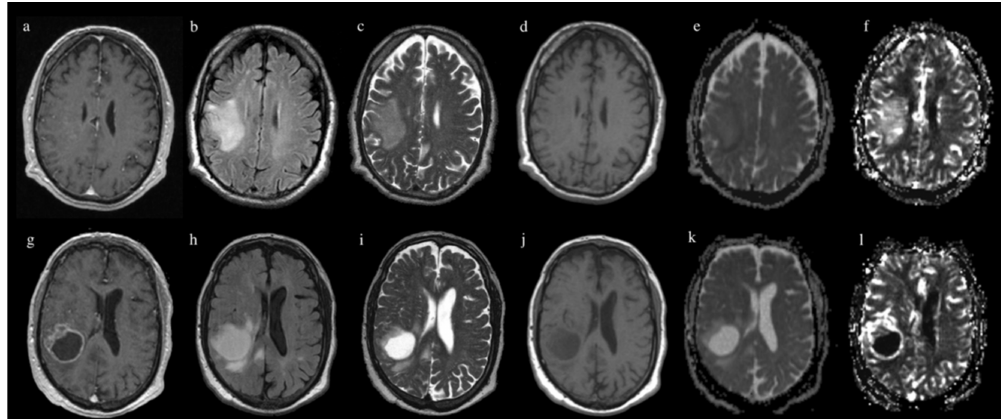
Figure 6. Examples of incorrectly predicted outcome (IDH mutation) from our CNN model. Images above show MPRAGE ( a ), FLAIR ( b ), T2 ( c ), T1 ( d ), ADC ( e ) and rCBV ( f ) sequences of a patient with IDH mutated GBM predicted as wild type (false negative). Images below show MPRAGE ( g ), FLAIR ( h ), T2 ( i ), T1 ( j ) ADC ( k ) and rCBV ( l ) sequences of a patient with IDH-wild-type GBM predicted as mutated (false